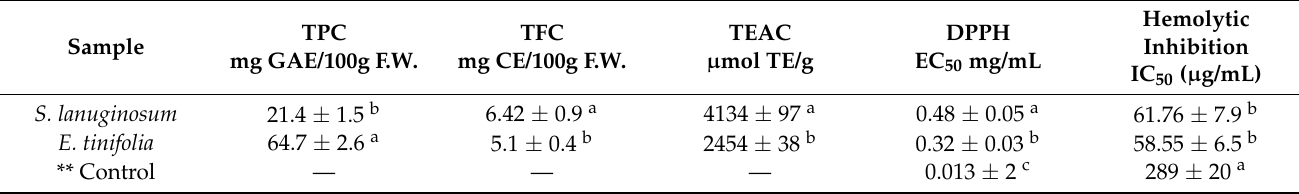
Table 1. Total phenolic content, total flavonoid content, and antioxidant/antiradical capacities of Ehretia tinifolia and Sideroxylon laniginosum